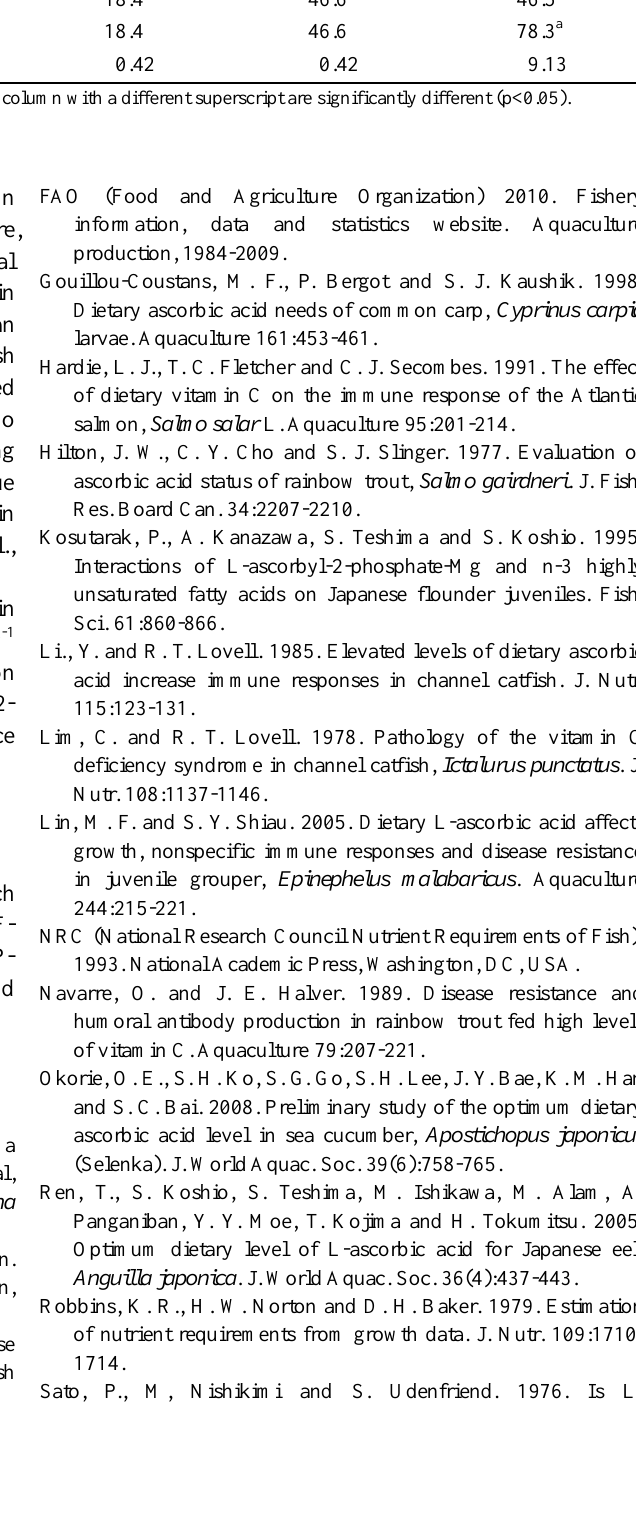
1 Values are means from triplicate groups of fish where the means in each column with a different superscript are significantly different (p<0.05). 2 Pooled standard error of mean: SD/ n . 3 Not